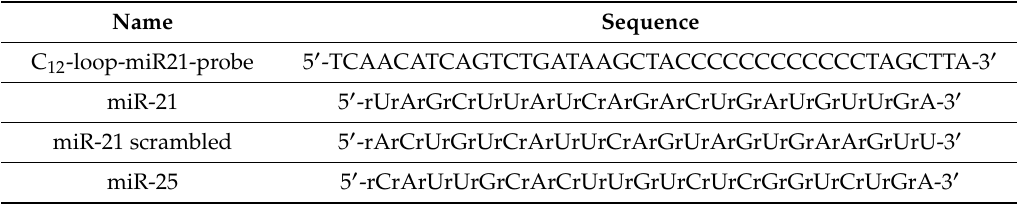
Table 1. Nucleic acid sequences used for the probe design and as target analyte